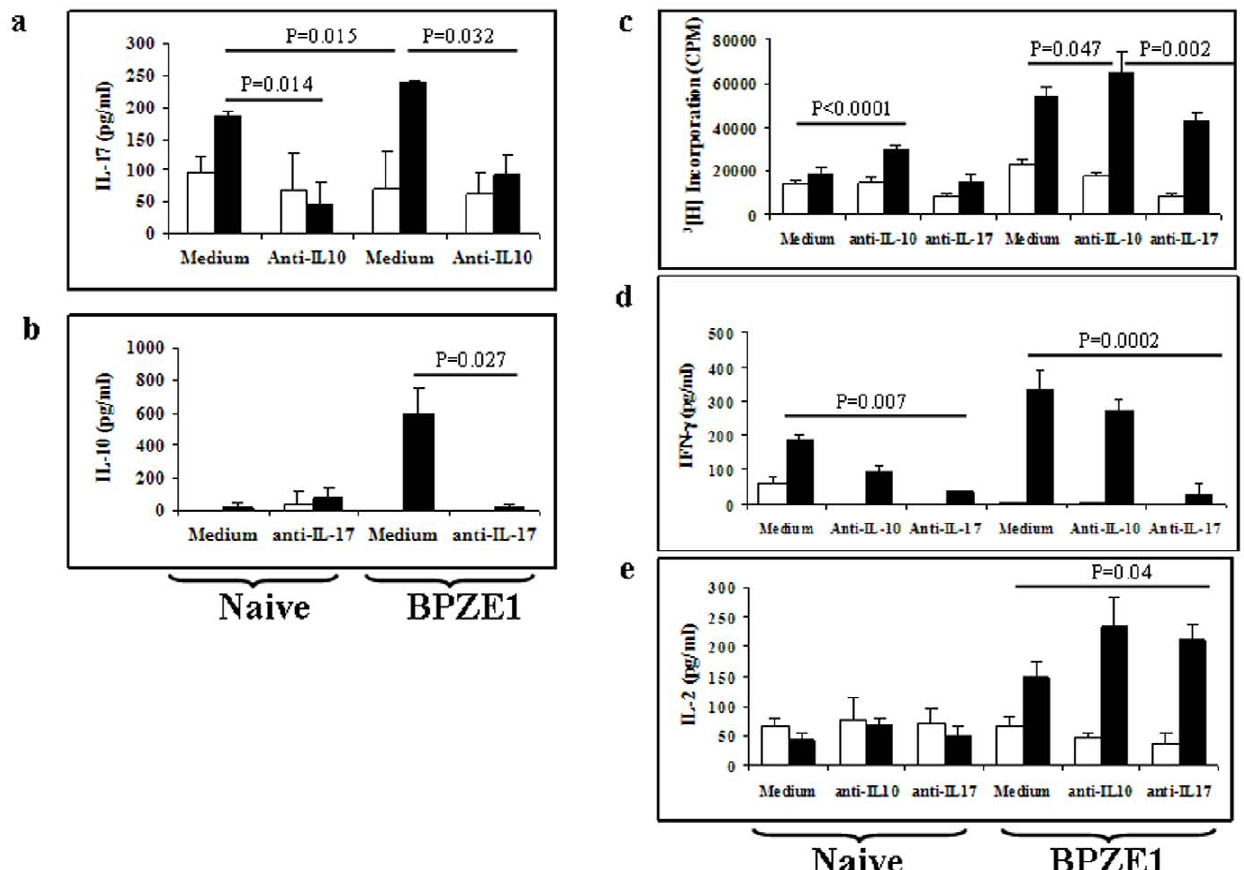
Figure 4. Cytokine production profile of splenocytes from BPZE1-immunized mice. BALB/c mice were left untreated (Naı¨ve) or immunized intranasally with 10 6 CFU of B. pertussis BPZE1 (BPZE1). Eight weeks later, the mice were sacrificed, and spleen cells were stimulated in triplicate in the presence (black bars) or absence (white bars) of 10 m g/ml FHA, with or without (Medium) 10 m g/ml anti-IL-10 or anti-IL-17 antibodies. After 60 h of culture, the secretion of IL-17 ( a ), IL-10 ( b ), IFN- c ( d ) and IL-2 ( e ) in the culture supernatants was determined by sandwich ELISA, and the proliferation was assessed by [ 3 H] thymidine incorporation ( c ). The results are the expressed as mean values ( 6 standard error) for triplicate cultures from four mice per group and are representative of three experiments.